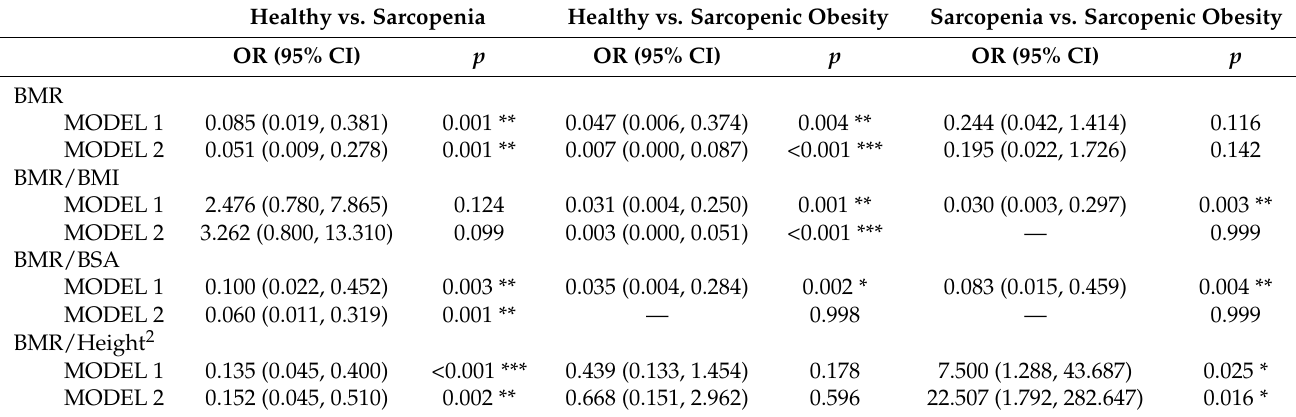
Table 3. Associations of BMR with sarcopenia and sarcopenic obesity. Healthy vs. Sarcopenia Healthy vs. Sarcopenic Obesity Sarcopenia vs. Sarcopenic